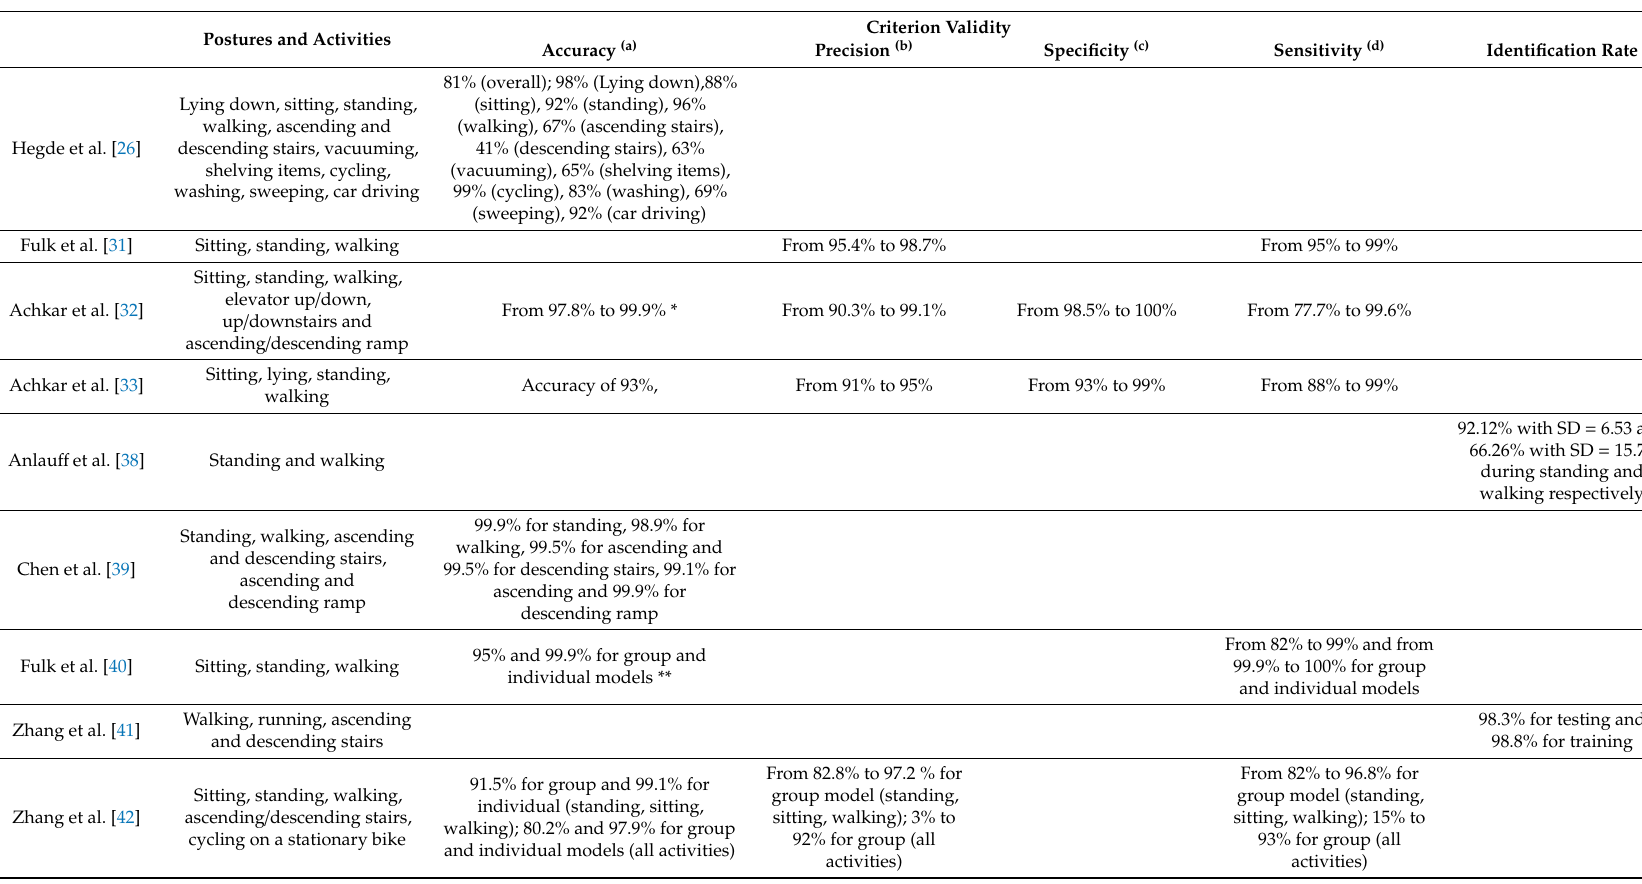
Table 4. Criterion validity of insoles for posture and activity